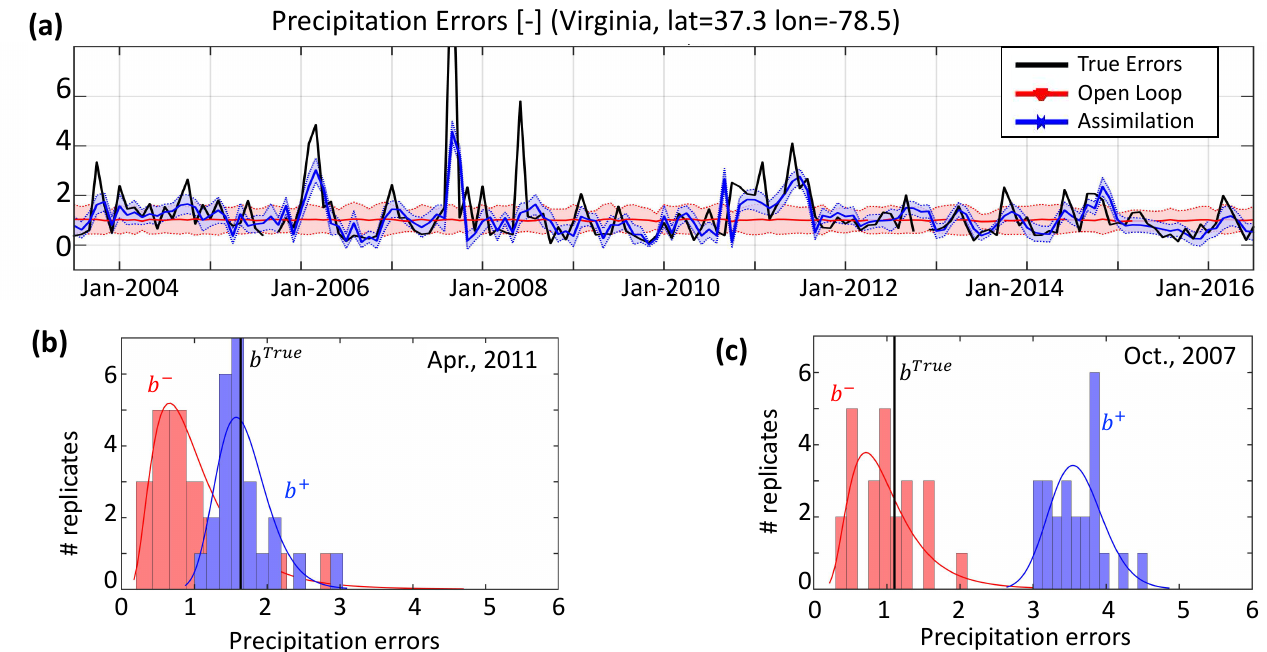
Figure 4. ( a ) Precipitation errors ( b j , m ) at a sample location in Virginia, United States (37.32 N, 78.46 W). ( b ) Ensemble of the precipitation error estimates from the open-loop (red) assimilation (blue) for April 2011 and ( c ) October 2007. Vertical black lines in ( b , c ) indicates the true precipitation